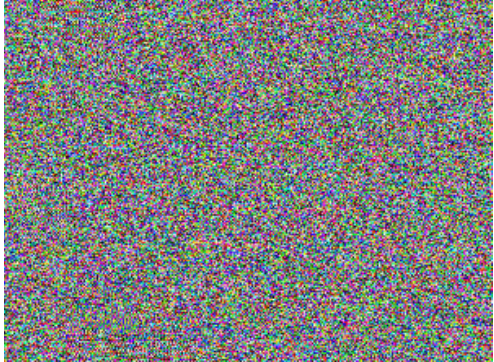
Figure 24. Post-encryption